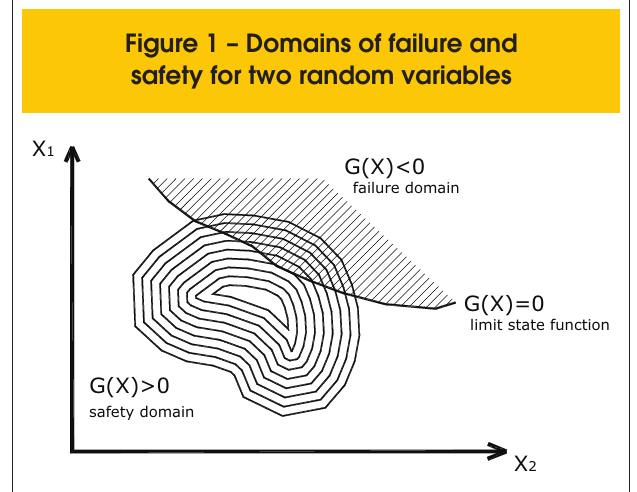
Figure 1 – Domains of failure and safety for two random